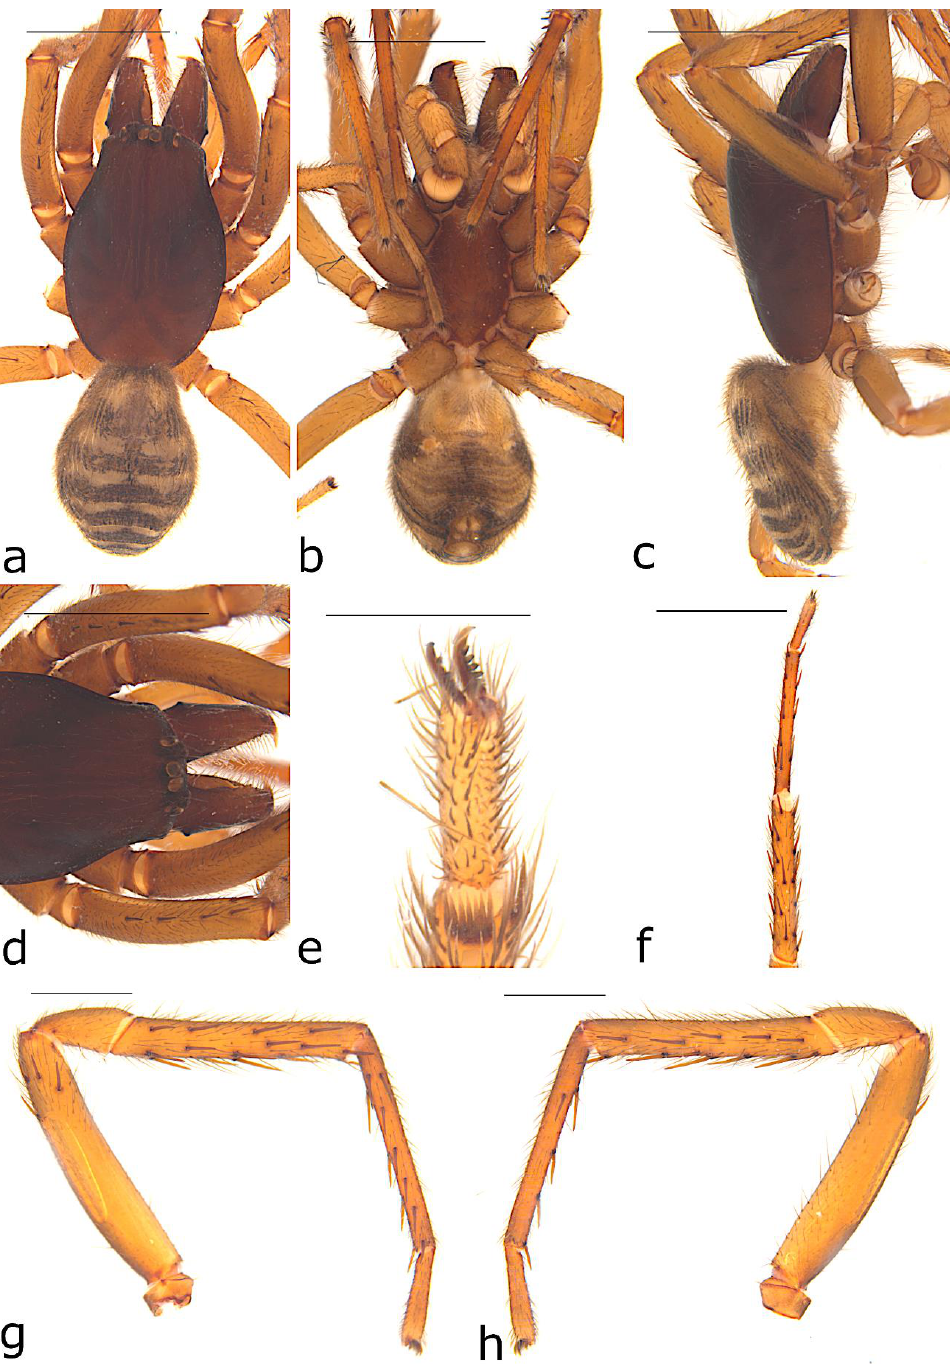
Figure 13. Ariadna sinuosa sp. nov. ♂ holotype (MV K-4989) from Mount Donna Buang (Vic): ( a ) habitus, dorsal view; ( b ) same, ventral view; ( c ) same, lateral view; ( d ) eyes, dorsal view; ( e ) left metatarsus IV, preening comb, retrolateral view; ( f ) left leg I, ventral view; ( g ) same, prolateral view; ( h ) same, retrolateral view. Scale bars ( a – d ) = 2 mm, ( e ) = 0.5 mm, ( f ) = 2 mm and ( g , h ) = 1 mm. Abdomen: 2.7 long. Dorsally with seven dark grey transverse abdominal striations on a pale-yellow base colour, striations connected by thin dark grey strip medially; ventrally with broad dark grey medial strip, laterally yellow-grey. With orange-brown setae (Figure